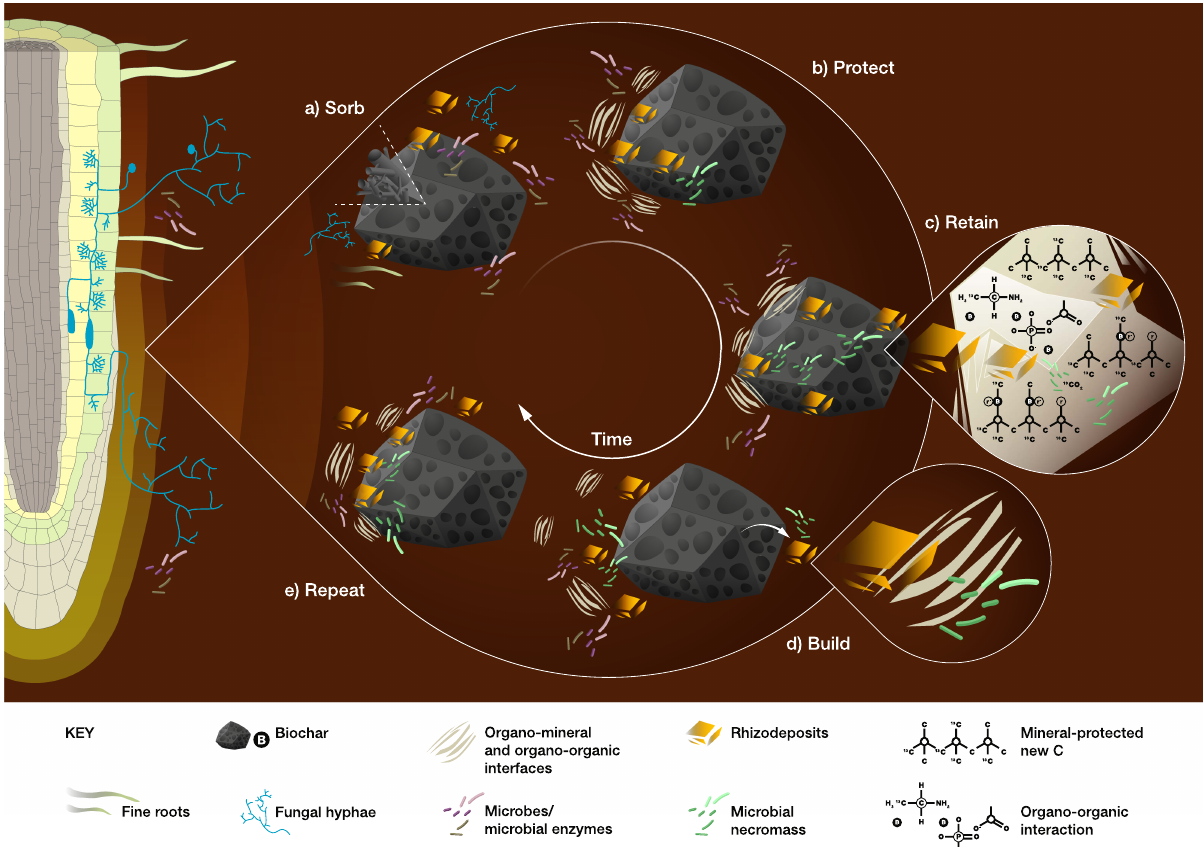
Fig. 1 | Conceptual diagram of the formation of protected aggregates from catalytic biocharsurfacesover timein a Rhodic Ferralsol. a Biocharsorbs root- derived carbon (rhizodeposits) onto its surface, protecting the rhizodeposits from immediate microbial consumption. b , c The rhizodeposits form organic interfaces with biochar, and organo-mineral interfaces with very fi ne layers of soil minerals